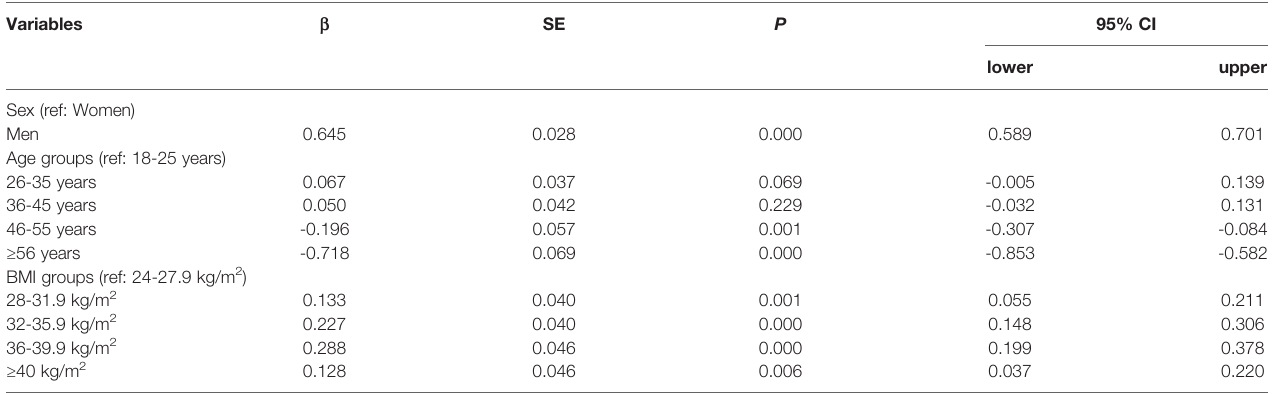
TABLE 3 | Independent in fl uence factors analysis for Chinese 50kHz-phase angle when age groups and BMI groups as categorical variables.